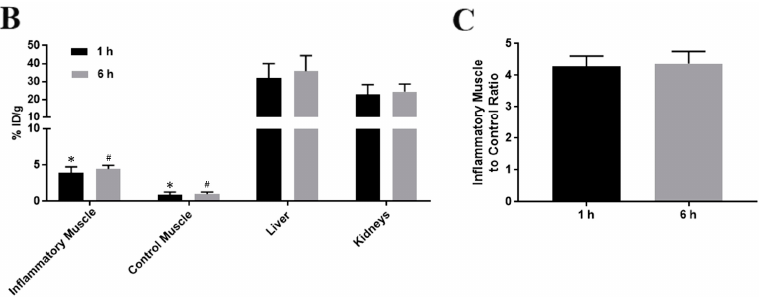
Figure 1. ( A ) Decay-corrected whole-body coronal small animal PET and PET/CT images of animal